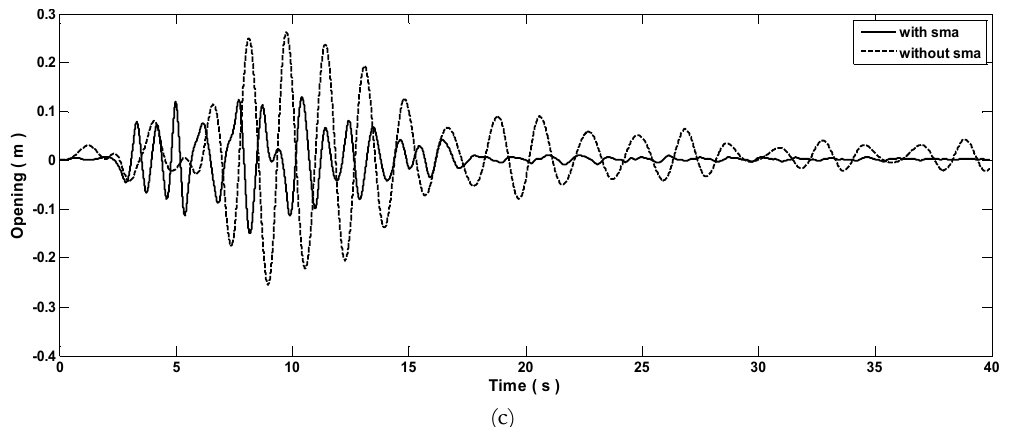
Figure 9: Comparison between the time histories of three hinges opening when using SMA and as–built bridge under the scaled 1989Loma Prieta record and period ratio ( ρ = 0.8), (a) Hinge 1; (b) Hinge 2; (c) Hinge